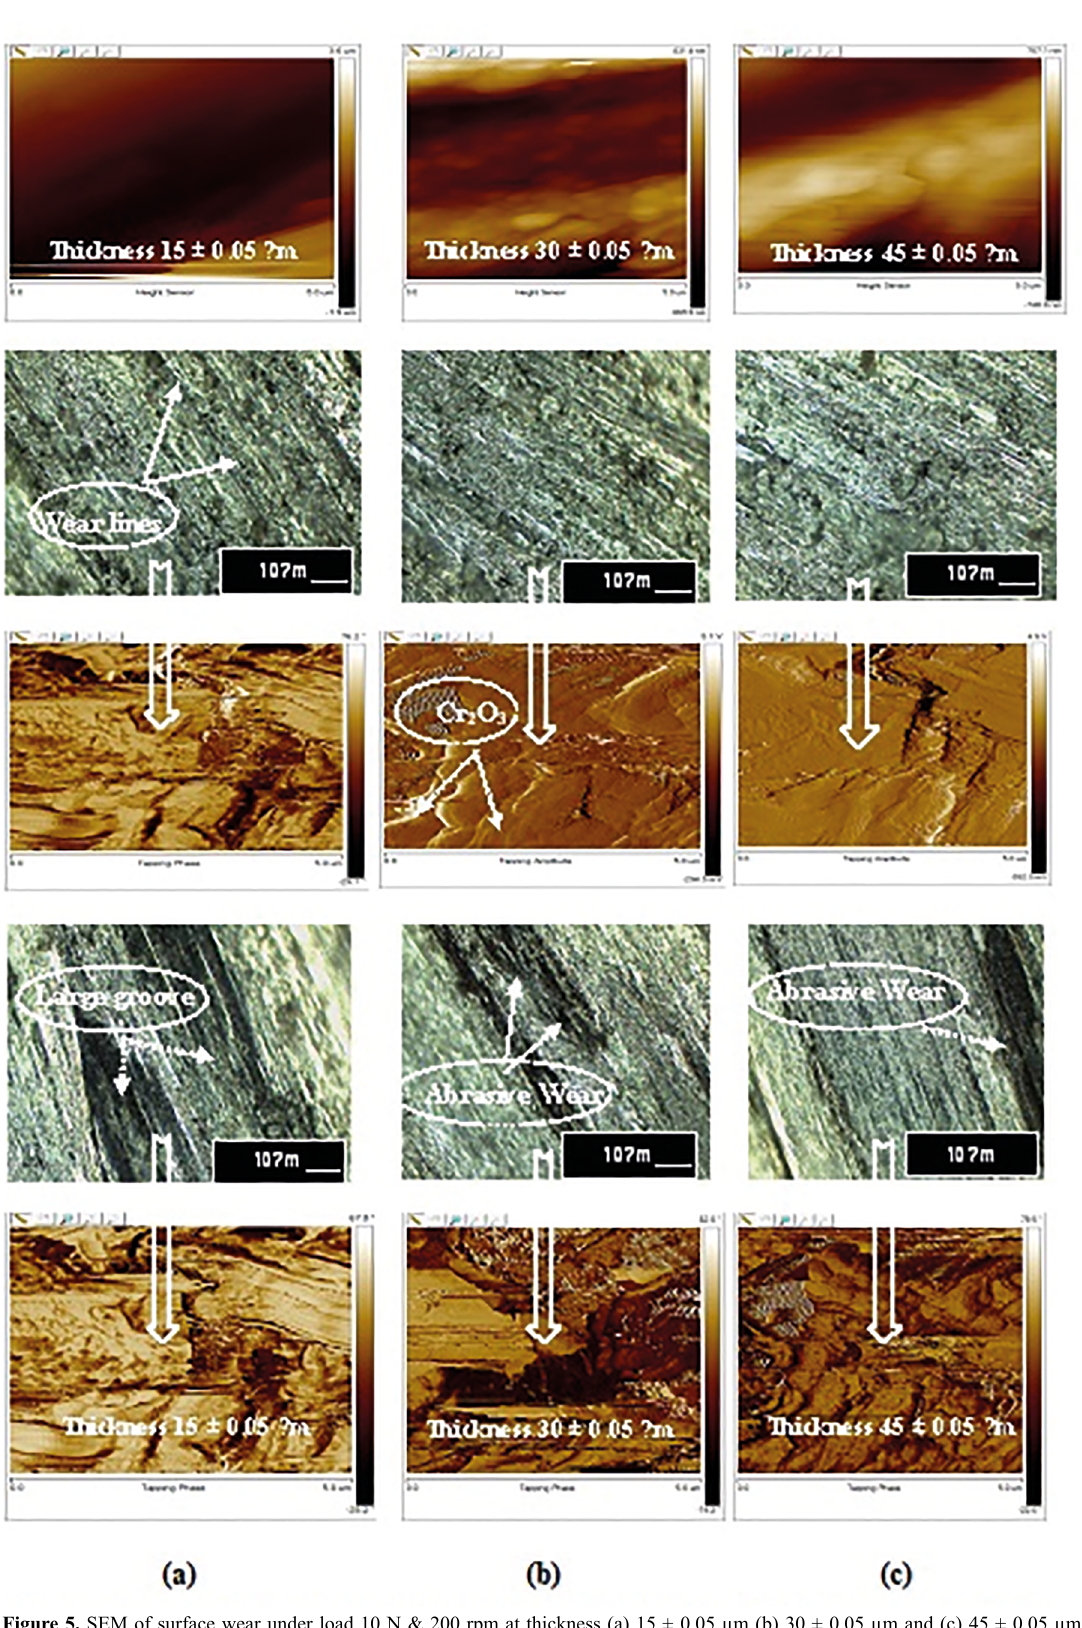
Figure 5. SEM of surface wear under load 10 N & 200 rpm at thickness (a) 15 ± 0.05 µm (b) 30 ± 0.05 µm and (c) 45 ± 0.05 µm, corresponding